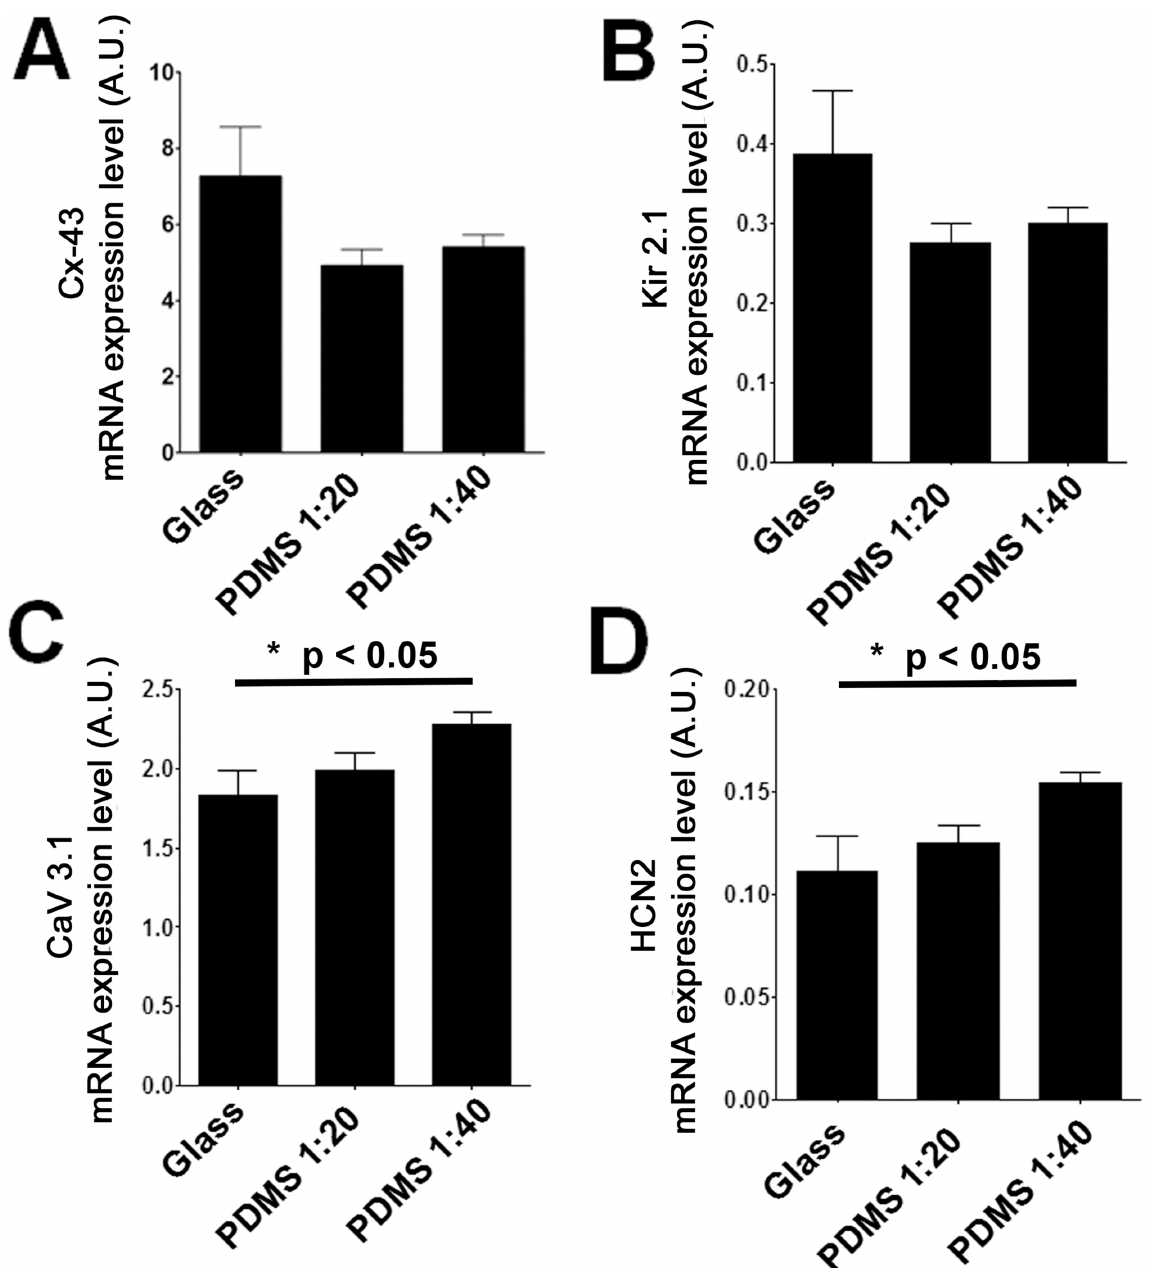
Fig 4. Role of the proteins expression on spontaneous activity. A. Cx43 mRNA expression was 6.24 ± 0.89, 4.55 ± 0.27 and 5.70 ± 0.12. According to our results, Cx43 mRNA expression has a tendency to be lower on PDMS substrates compared to glass, however, significant differences was detected between PDMS 1:20 and PDMS 1:40. B-D. mRNA expression of targeted proteins playing a role on automaticity through the voltage clock could explain the small changes observed in rhythm. Kir2.1 (B) mRNA expression tends to be lowered when cardiomyocytes are cultivated on PDMS compared to glass. There is a tendency towards increased expression of CaV3.1 (C) and HCN2 (D) on PDMS compared to glass (p < 0.05, between glass and PDMS 1:40).